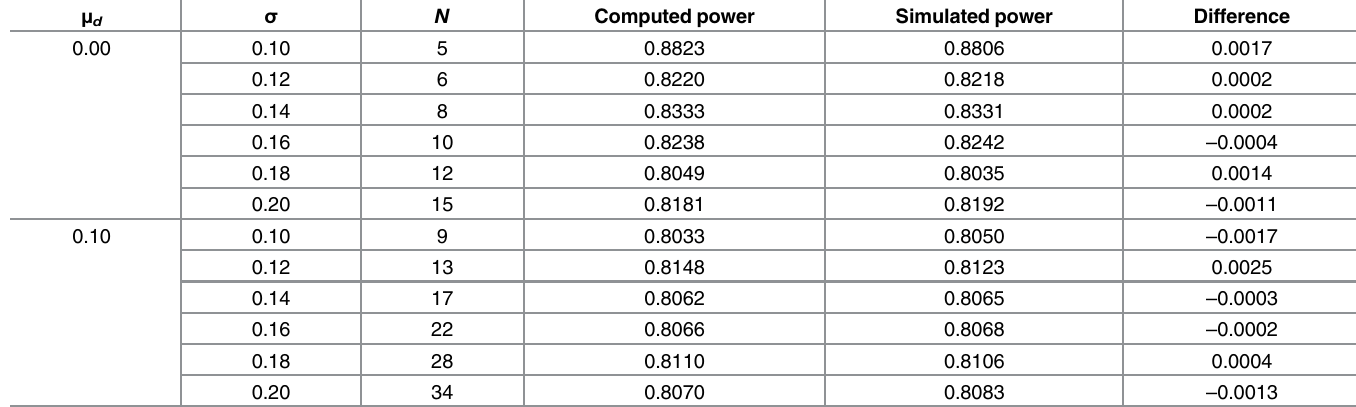
Table 1. The computed power and simulated power of the two one-sided test for α = 0.05, Δ = 0.2231, and equal sample sizes N 1 = N 2 = N . μ d